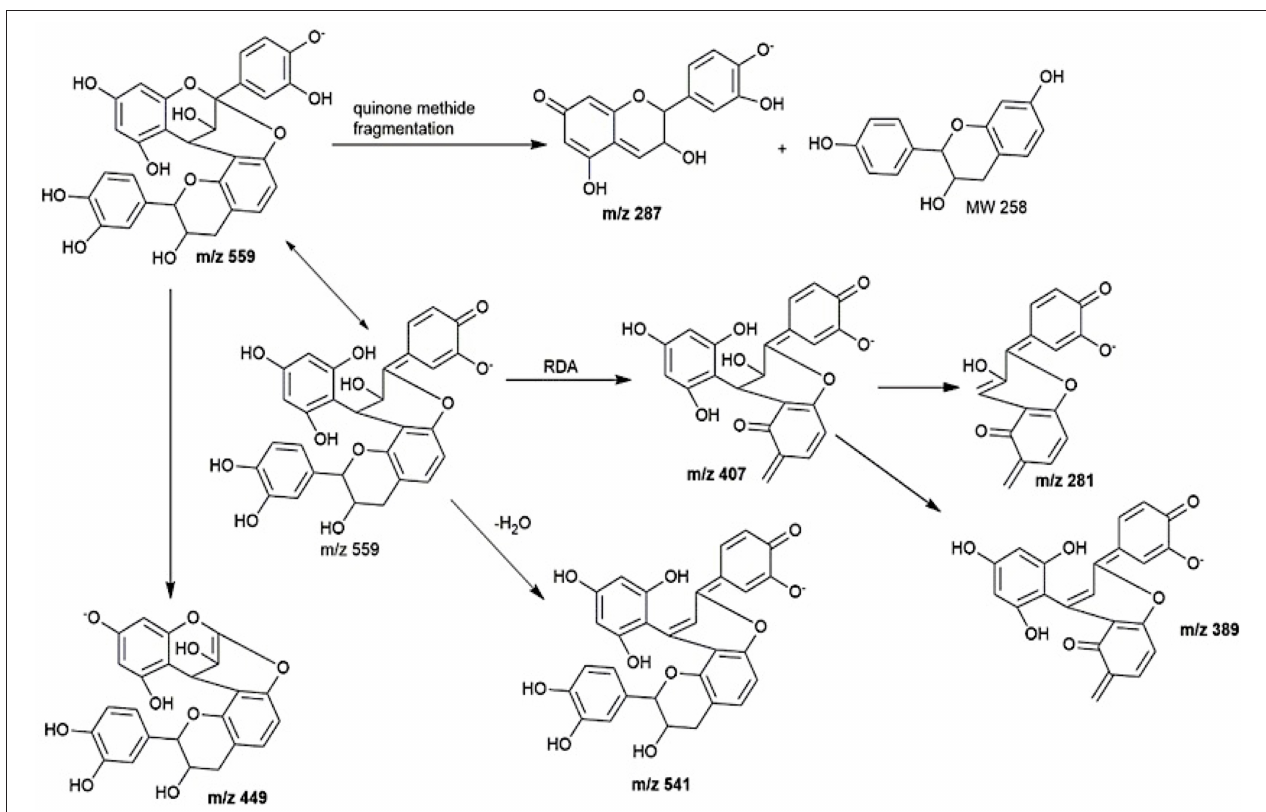
FIGURE 3 | HPLC chromatogram of EA fraction under UV 280nm and the compounds associated to the major